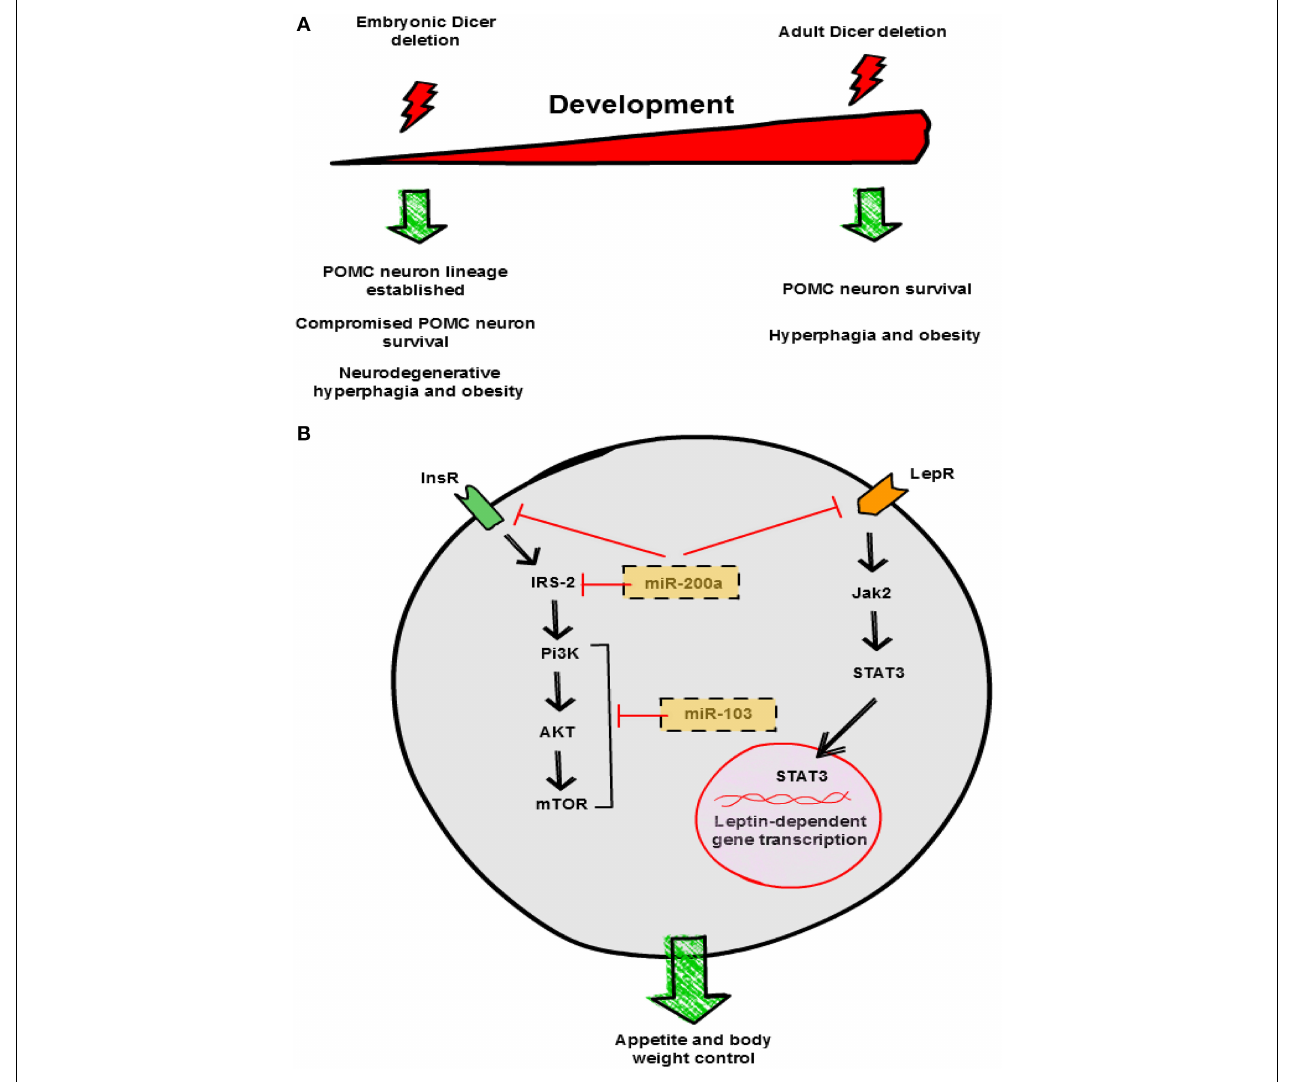
FIGURE 2 | Hypothalamic miRNAs control energy balance. (A) Divergent effects of Dicer deletion on survival of hypothalamic neurons. Loss of Dicer in POMC neurons during embryonic development does not interfere with neuronal lineage establishment but leads to post-natal neurodegeneration. In contrast, lack of Dicer in the adult does not interfere with POMC neuron viability. Both experimental manipulations